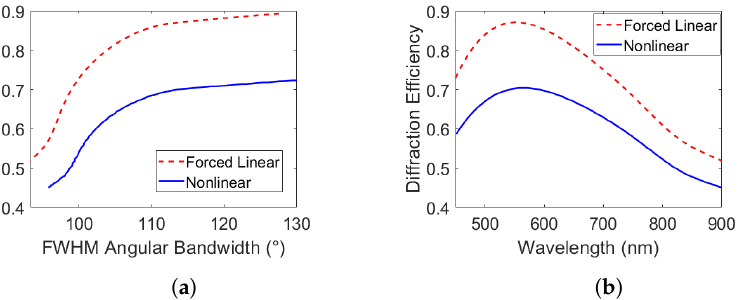
Figure 7. Diffraction efficiency for linearized and nonlinear phase profiles with respect to ( a ) angular bandwidth, and ( b ) wavelength at normal